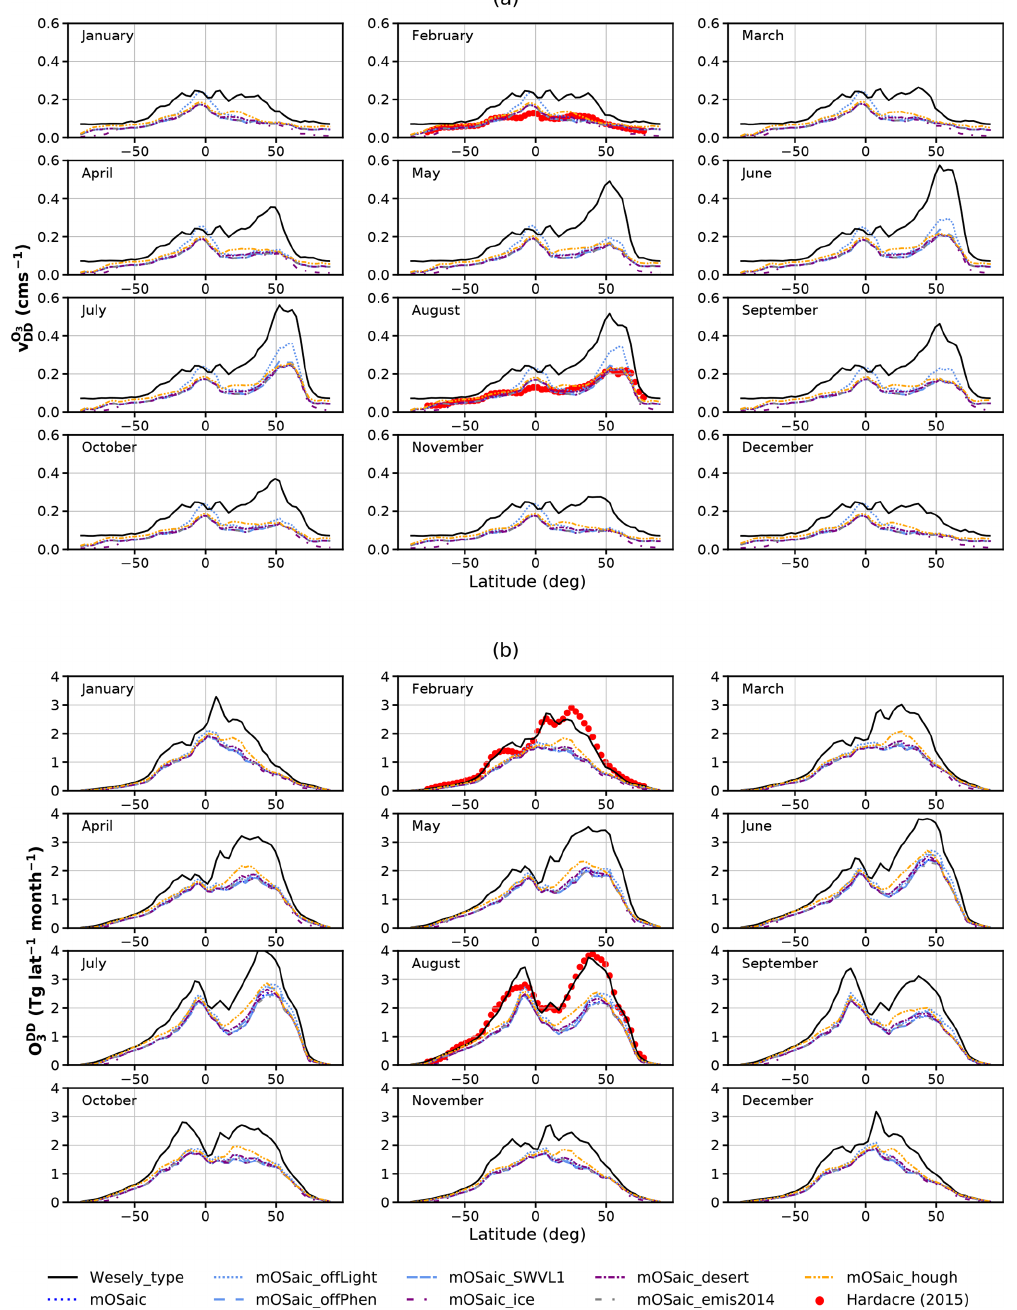
Figure A1. Comparison of the manifold Oslo CTM3 integrations with respect to (a) zonal average ozone dry deposition velocities and (b) total annual amount of ozone removed from the atmosphere via dry deposition. The multi-model mean from the evaluation of TF HTAP models by Hardacre et al. (2015) is shown as a reference (where